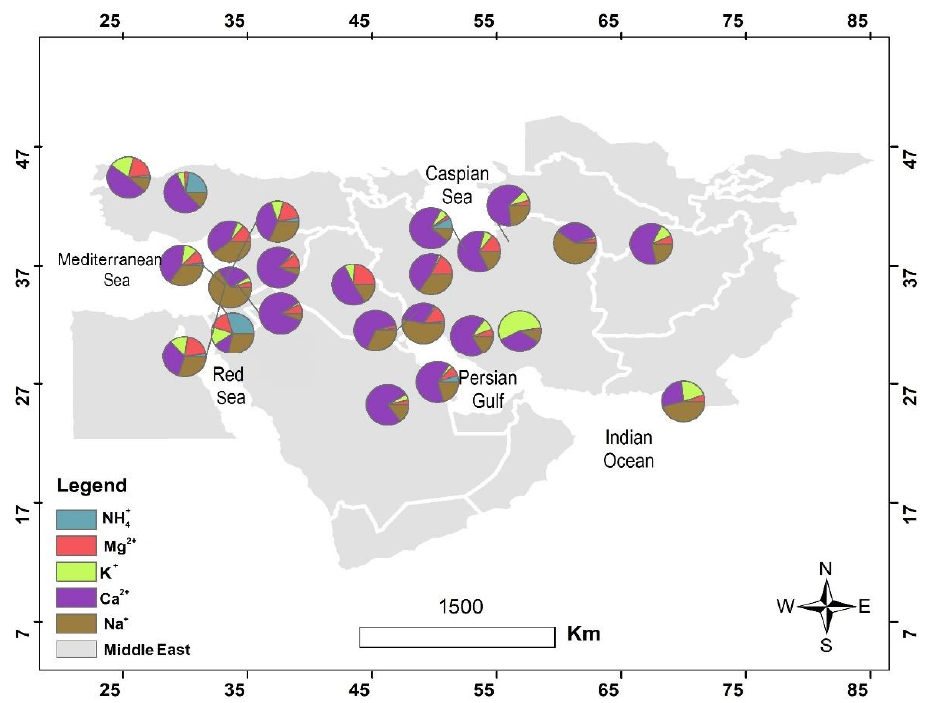
Figure 4. The variations in major cations in the precipitation at the studied stations across the Middle East.